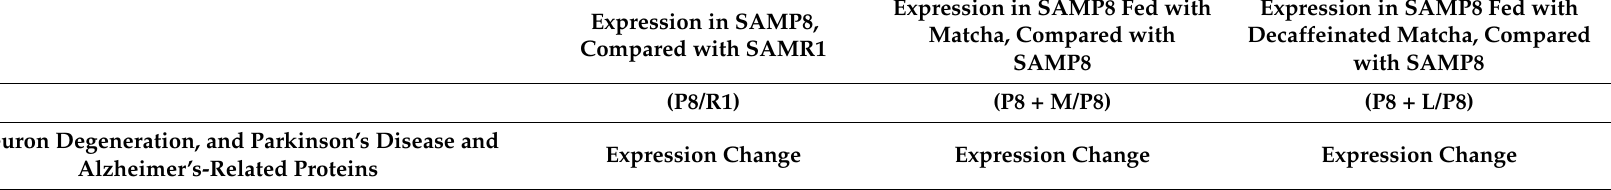
Expression Change Expression